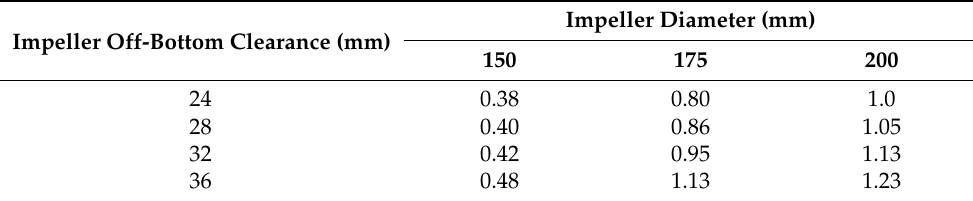
Table 3. Maximum vertical velocity (m·s −1 ) that was found at each measuring line at the related impeller diameter and off-bottom clearance.